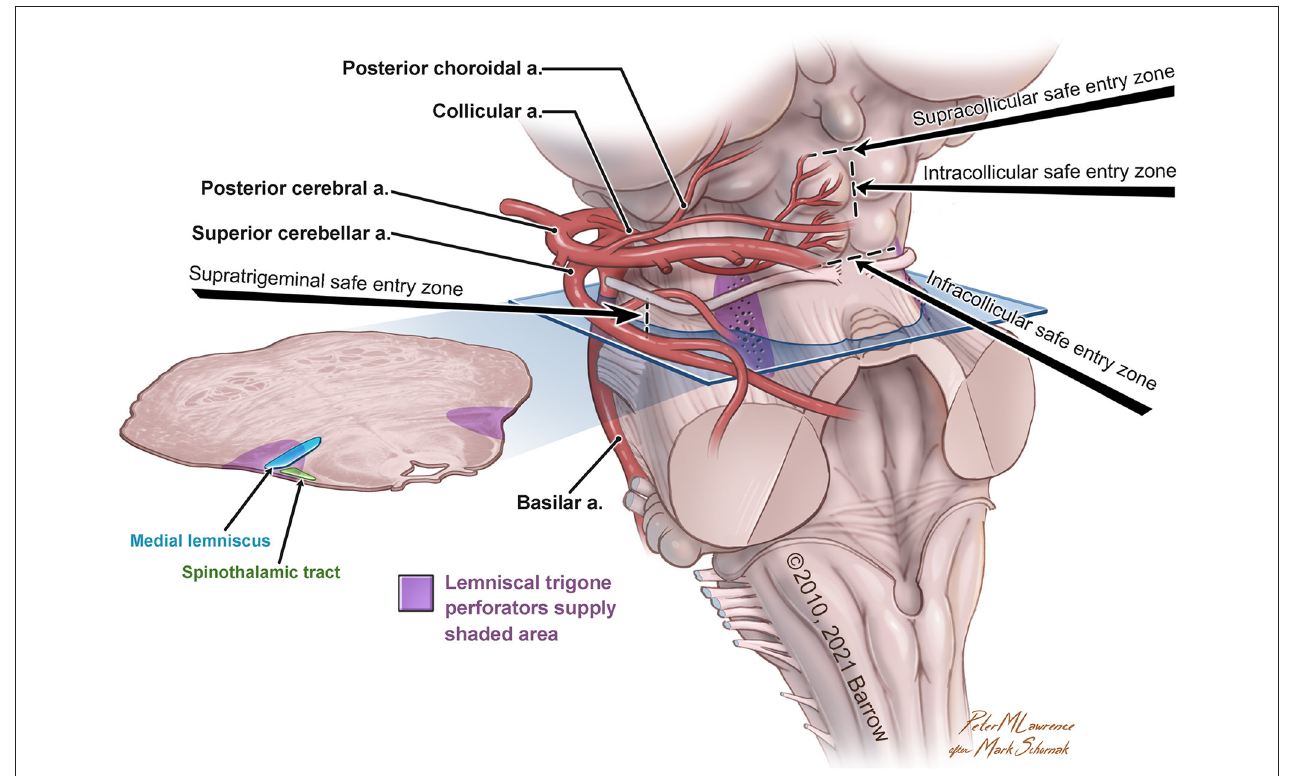
FIGURE 1 | Anatomical illustration of the lemniscal trigone zone. a., artery. Used with permission from Barrow Neurological Institute, Phoenix, Arizona.